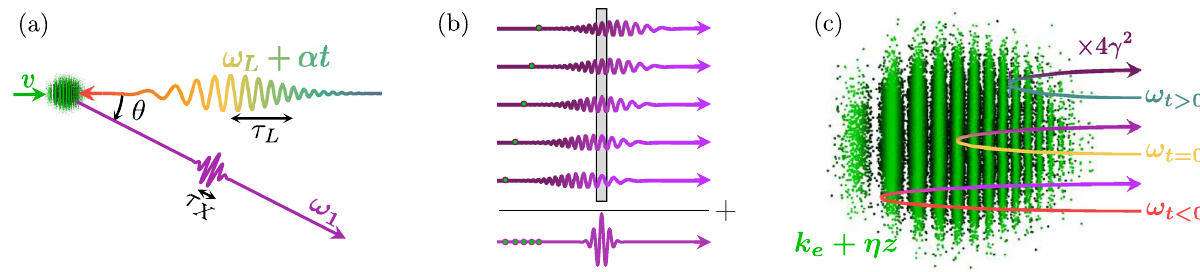
Figure 1. ( a ) Attosecond X-ray pulse (purple) generation by colliding microbunched electrons (green) on a chirped laser pulse (gradient). ( b ) Single electron radiation fields (purple gradient) of axially separated electrons (green) and the resulting superradiant beat (purple). The grey box illustrates the part that contributes to superradiance. ( c ) A relativistic chirped electron mirror has a frequency dependent depth at which superradiance